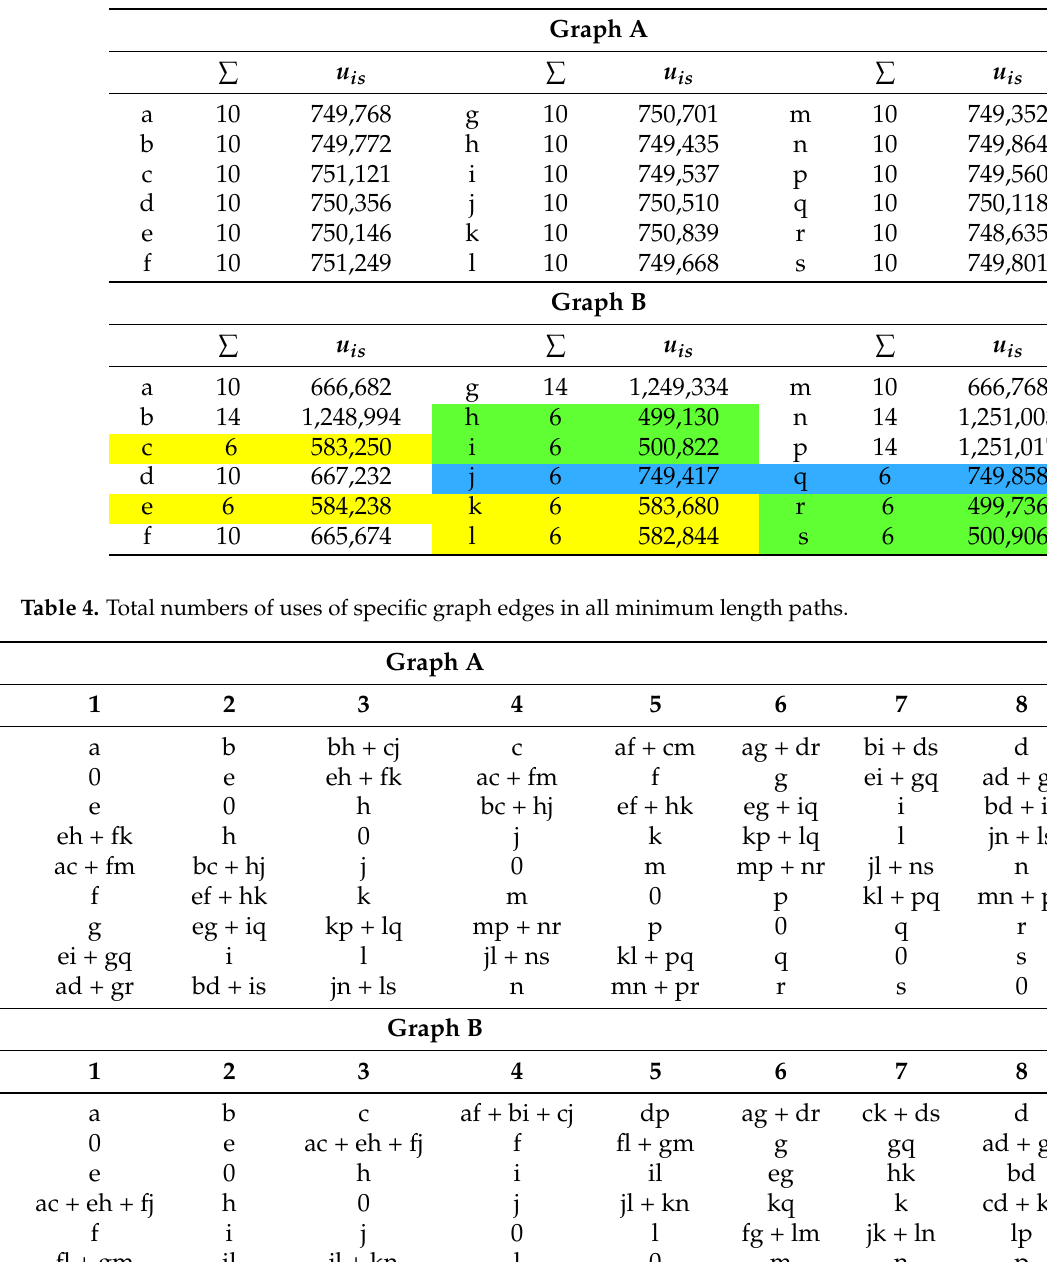
Table 3. Distribution of the use of graph edges resulting from the simulation.